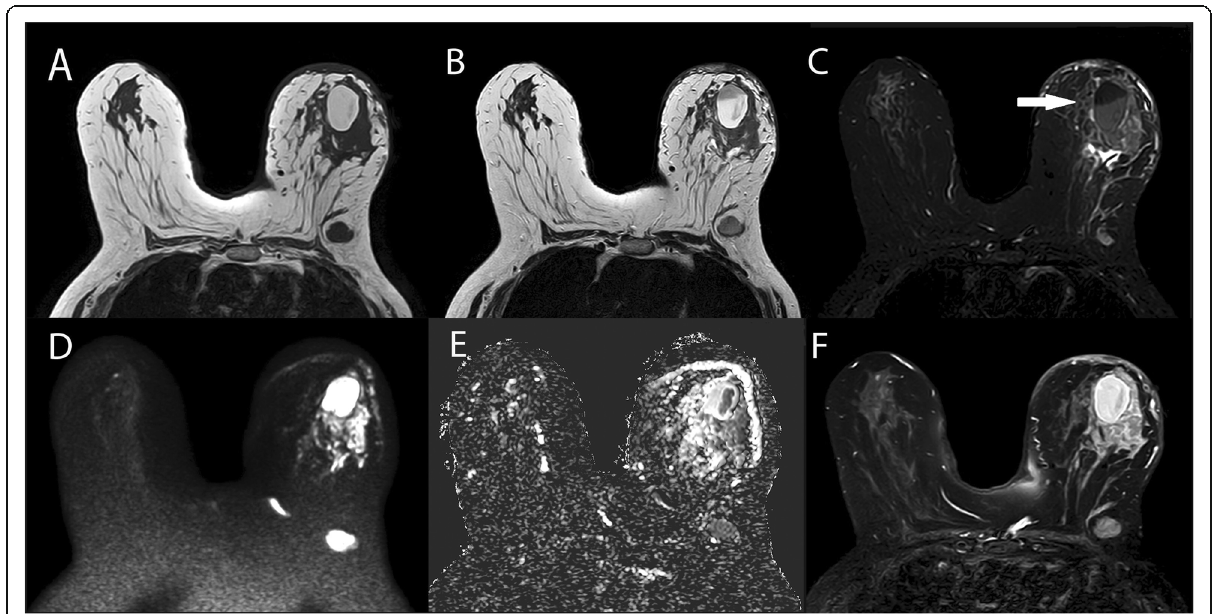
Fig. 3 In the left breast, there was an irregular mass of iso T1 SI ( a ), intermediate high T2 SI ( b ), high STIR ( c ) with strong restricted diffusion in DWI ( d ), low ADC value ( e ), and strong enhancement in post-contrast scan ( f ). It was associated with skin thickening and edema as well as suspicious axillary lymph node. Eccentric within the mass was a thin walled cyst of high T1 SI ( a ), high T2 SI ( b ), and bright in DWI ( d ), but for being suppressed in STIR sequence ( c , arrowed), the probability of fatty versus hemorrhagic content was equivocal. In the post-contrast sequence ( f ), in which fat frequency-selective saturation technique was used, the cyst was not suppressed indicating it was hemorrhagic and not fatty. Also, an intracystic extension of the malignant lesion could not be defined within the hyperintense contents. The histopathology confirmed it was